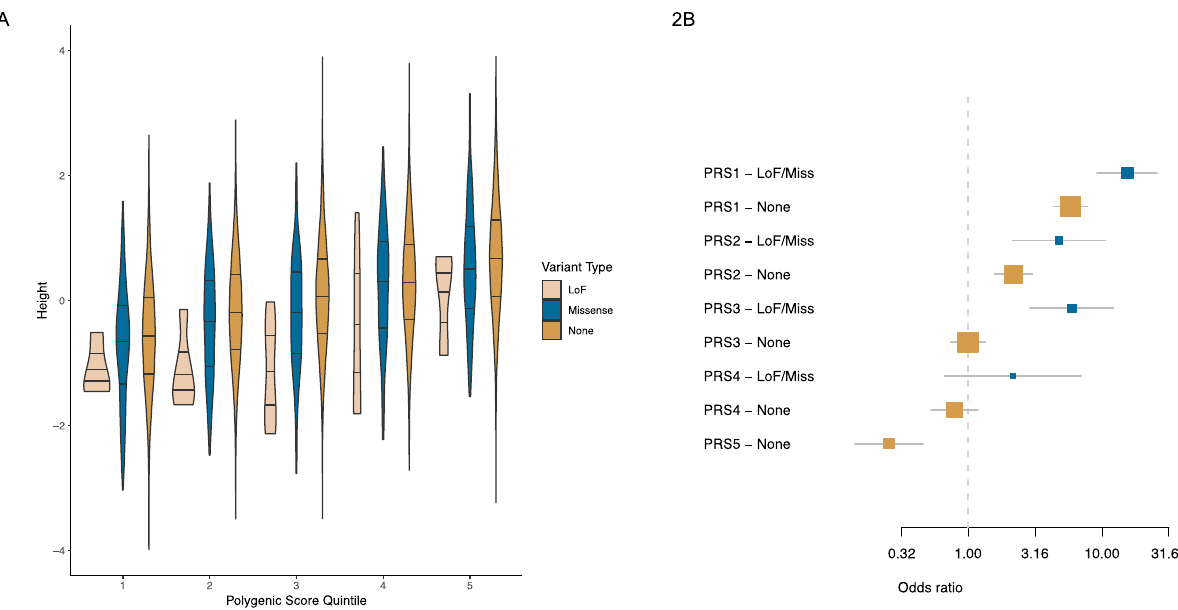
Fig. 2 Effect of rare coding variants on bidirectional effect genes for height. A Combined effect of PS and rare coding variants on height as a quantitative trait. Samples were divided in fi ve groups based on their PS. Horizonal lines in violin plots represent the 25%, 50% and 75% percentile of height. Samples were grouped by carrying status of missense (blue), loss of function (pink), or none (orange) in any of the fi ve core genes. B Combined effect of PS and rare coding variants on odds ratios for “ idiopathic short stature ” or ISS. Odds for ISS using non-carriers of NPPC, NPR2, FGFR3, SHOX , and IGF1R with PS = 3 as reference vs the other PS groups. Box colors represent: orange, non-carriers of LoF/missense variants in the fi ve genes; blue, carriers of LoF/missense variants in the fi ve genes. Measure of center for the error bars represent the estimated odds ratios and error bars represent 95% con fi dence intervals. Cases n = 572; control n =